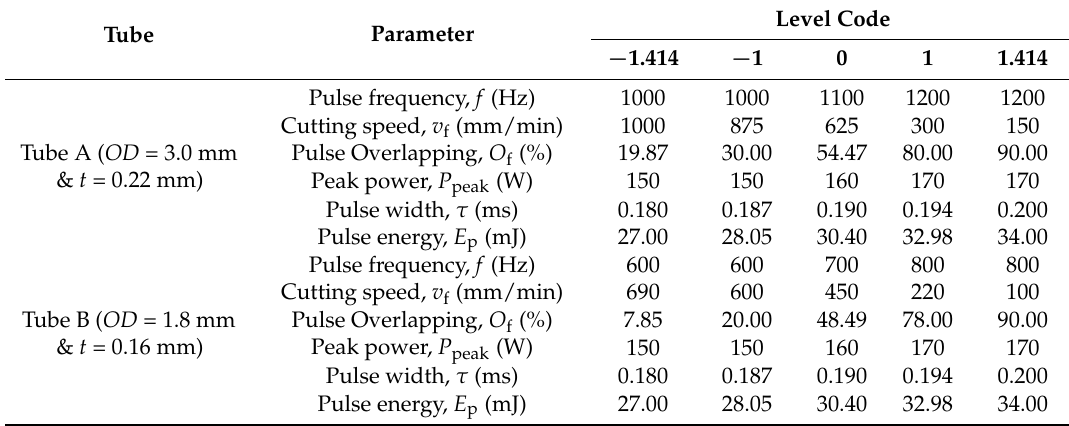
Table 7. Results with average R a and back-wall dross without gas blowing through the tube.